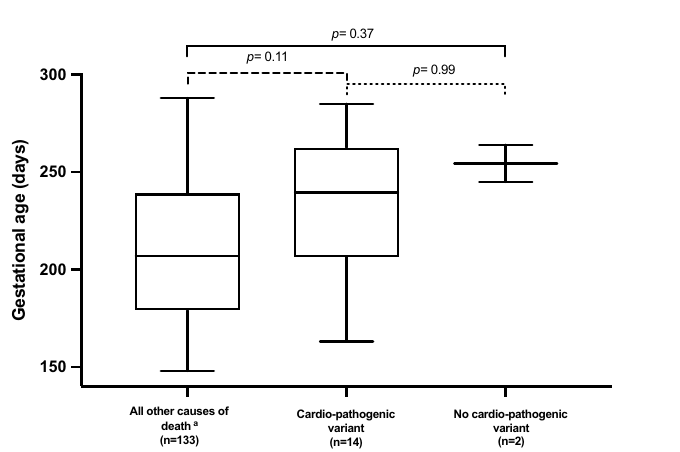
Figure 2. Comparison of median gestational age at time of stillbirth (in days) between fetuses with (n = 14) or without (n = 2) cardio-pathogenic variants and all cases of fetal death due to other causes (n = 133) as assessed by Kruskal–Wallis test with Dunn’s multiple comparisons. Superscript a: Causes of death (as per Tulip Classification): Placental dysfunction, cord complications, infection, “others”: e.g. fetal hydrops of unknown origin; maternal disease; fetal/maternal trauma. Excluded: congenital malformations (n = 32) and unknown because important information missing (n =